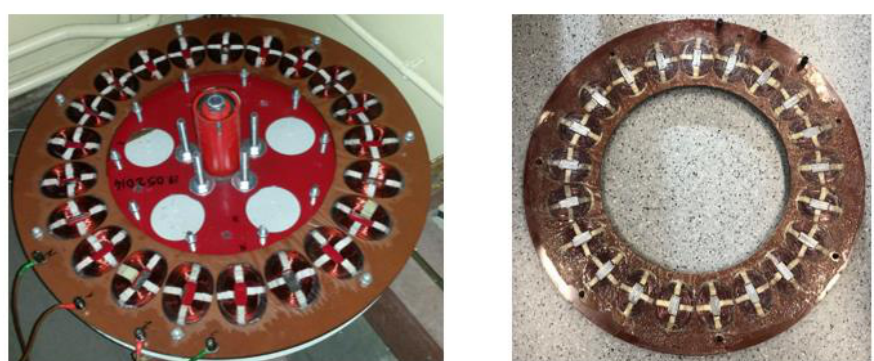
Figure 17. Laboratory set.